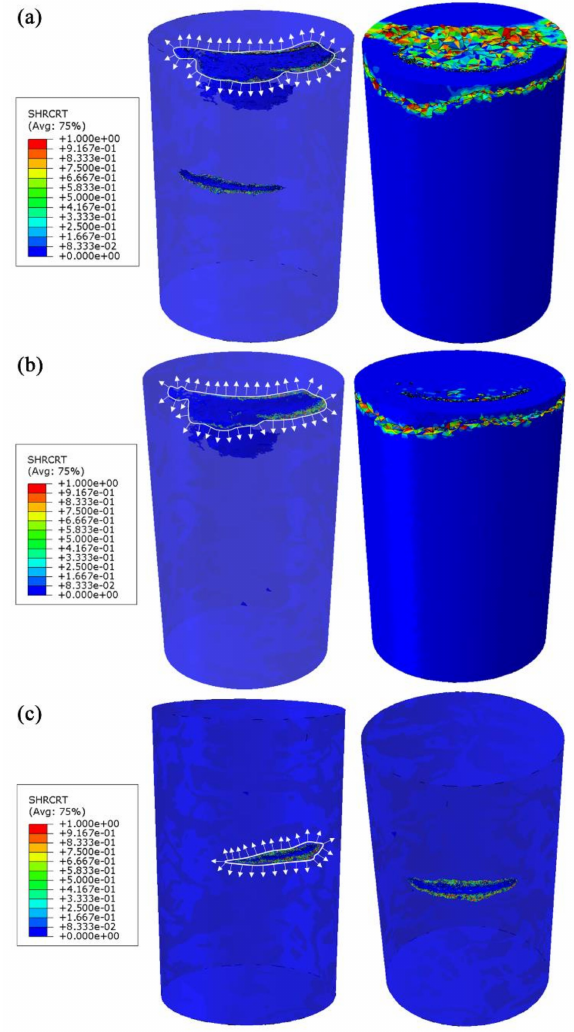
Figure 13. Damage variable distributions for Model 4 ( a ), Model 2 ( b ), and Model 3 ( c